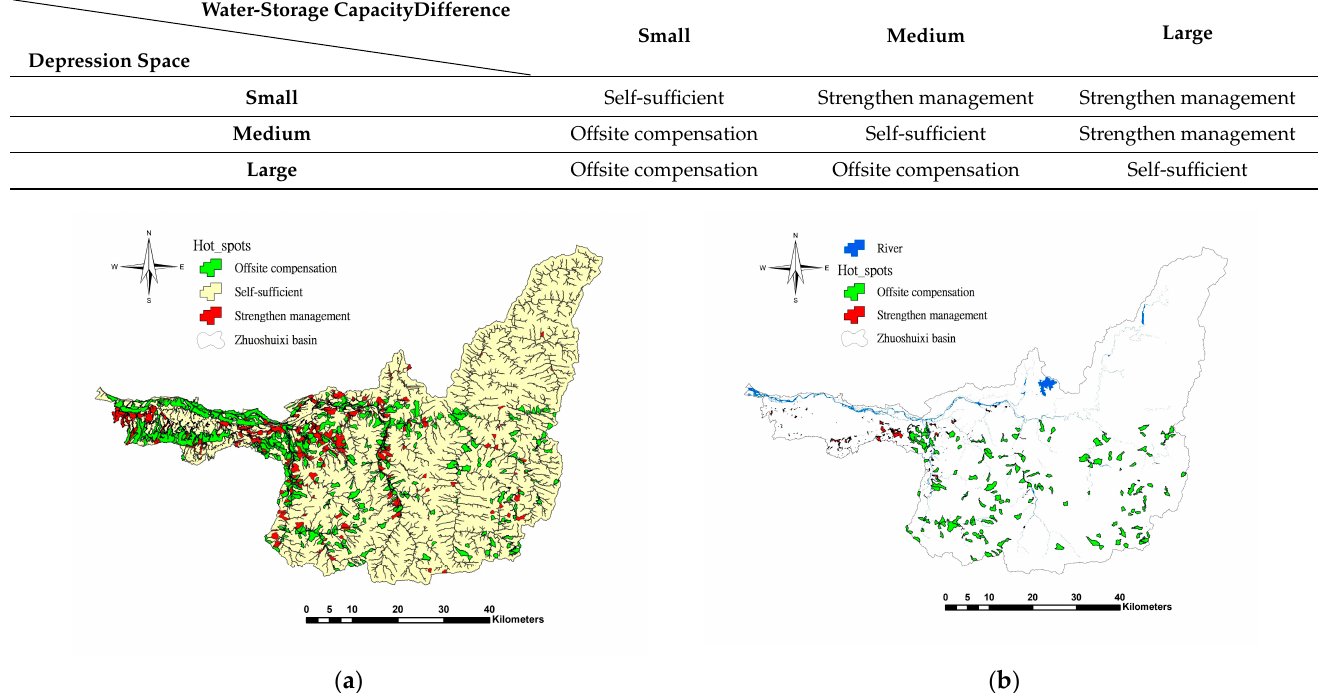
Figure 13. ( a ) The spatial relationship between runoff generation and flood storage and ( b ) location of the best off-site compensation and strengthened management.